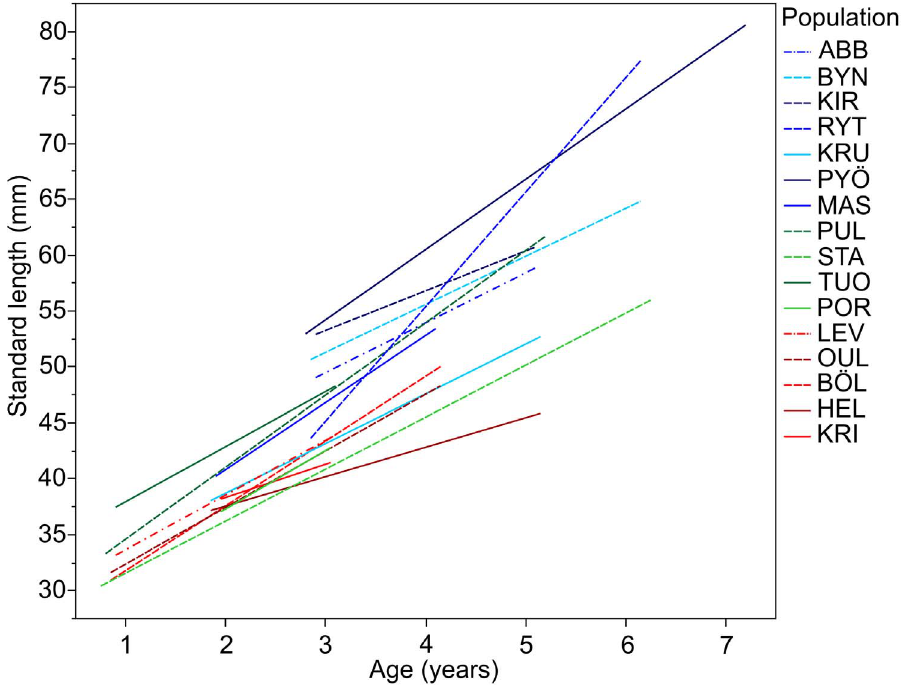
Figure 3. Mean body size of nine-spined sticklebacks as a function of age in different localities. Green=lakes; blue=ponds; red=marine.